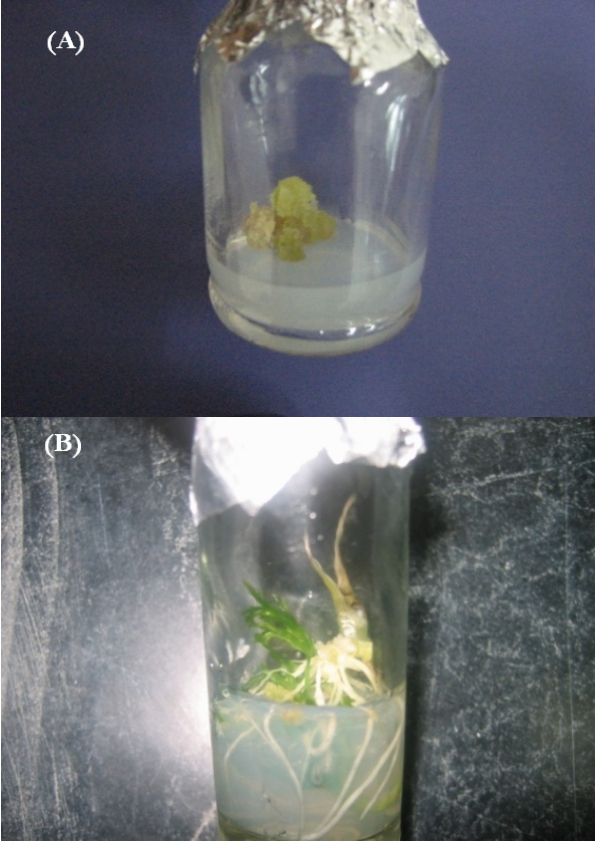
Fig. 1. (A) Induction of callus from the cotyledon of Foenicu- lum vulgare on MS media containing 1 mg l -1 IAA plus 1 mg l -1 2,4-D and 2 mg l -1 kinetin. (B) Regeneration from the callus of Foeniculum vulgare on MS media containing 2 mg l -1 NAA and 0.5 mg l -1